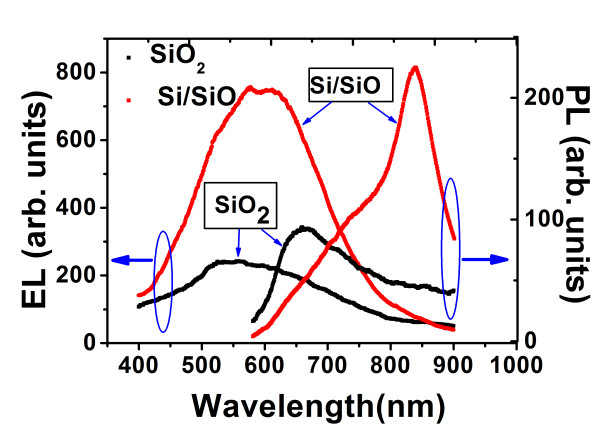
The PL and EL spectra from one Si/SiO sample and the sample of SiO2.